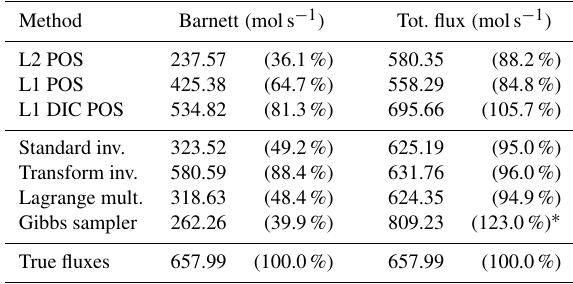
Table 2. Results for the Barnett scenario: estimated emissions in the Barnett region (red boxes in Fig. 11) and total flux change in- duced by the additional source for the methods of this study and the previous study by Miller et al. (2014).